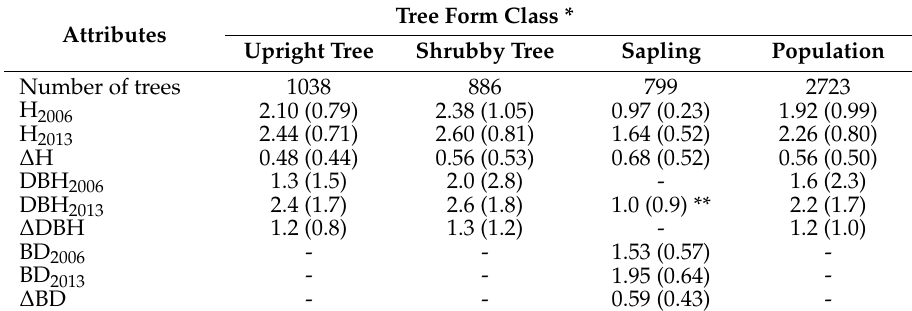
Table 1. Number of trees, mean height, and diameter ( ± 1 standard deviation) in 2006 and 2013 for Erman’s birch with different tree forms, growing in the alpine treeline ecotone on Changbai Mountain,